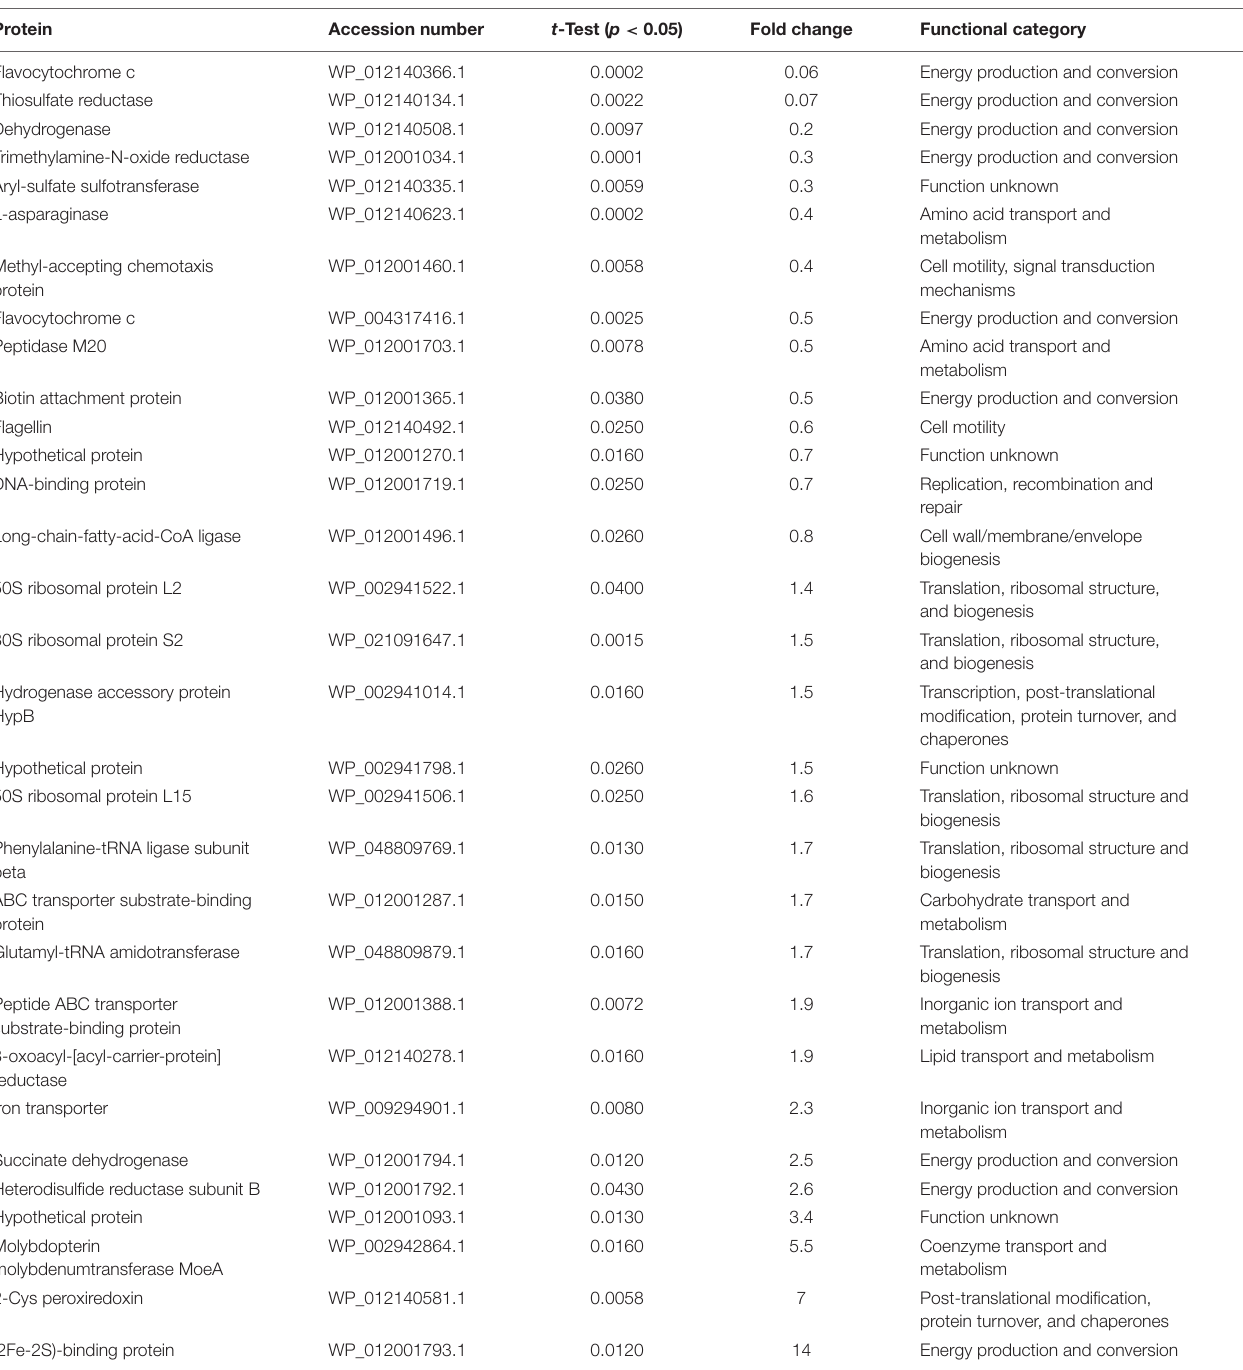
TABLE 6 | Proteins with a significant changed of expression profile when cultured on HBA plates and on HBA fum0 . 4 .